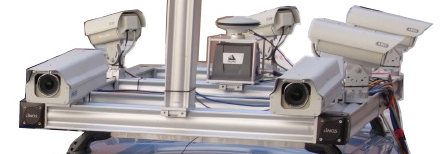
Figure 2. Sensor configuration of our vehicle-based mobile mapping system for the campaign in Basel in July 2014 which captured image sequences 1.0, 2.0 and 3.0